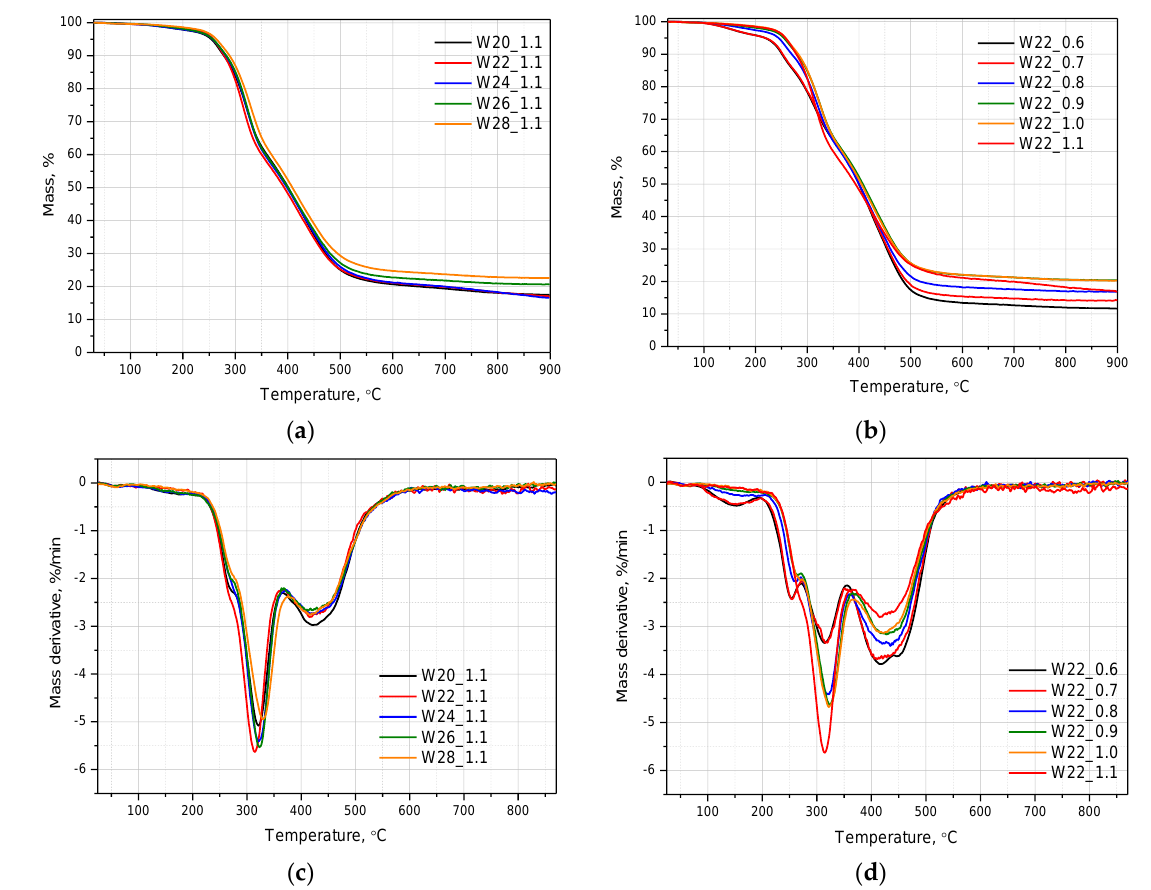
Figure 12. TG and DTG curves of polyurethane open-cell PU foams with different amounts of chemical blowing agent ( a , c ), and different isocyanate index ( b , d ). Table 7. Thermal properties of PU foams obtained by